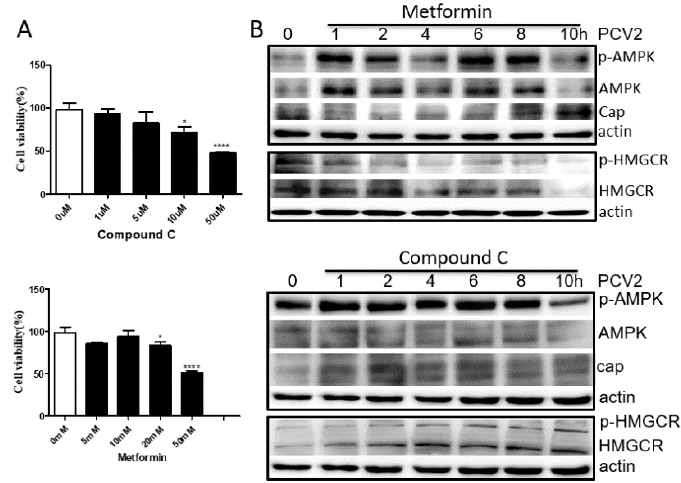
Figure 4. HMGCR activity is mainly regulated by AMPK during PCV2 infection. Cells were treated with compound C (AMPK inhibitor) or metformin (AMPK activator) and infected with PCV2, and analyzed by western blot at the indicated time points. The results are expressed as the mean ± SD of three independent experiments. The experiments were repeated at least three times. *, p < 0.05, ***, p < 0.001, and ****, p < 0.0001. ( A ) Cytopathic effects of drugs. ( B ) Western blot.